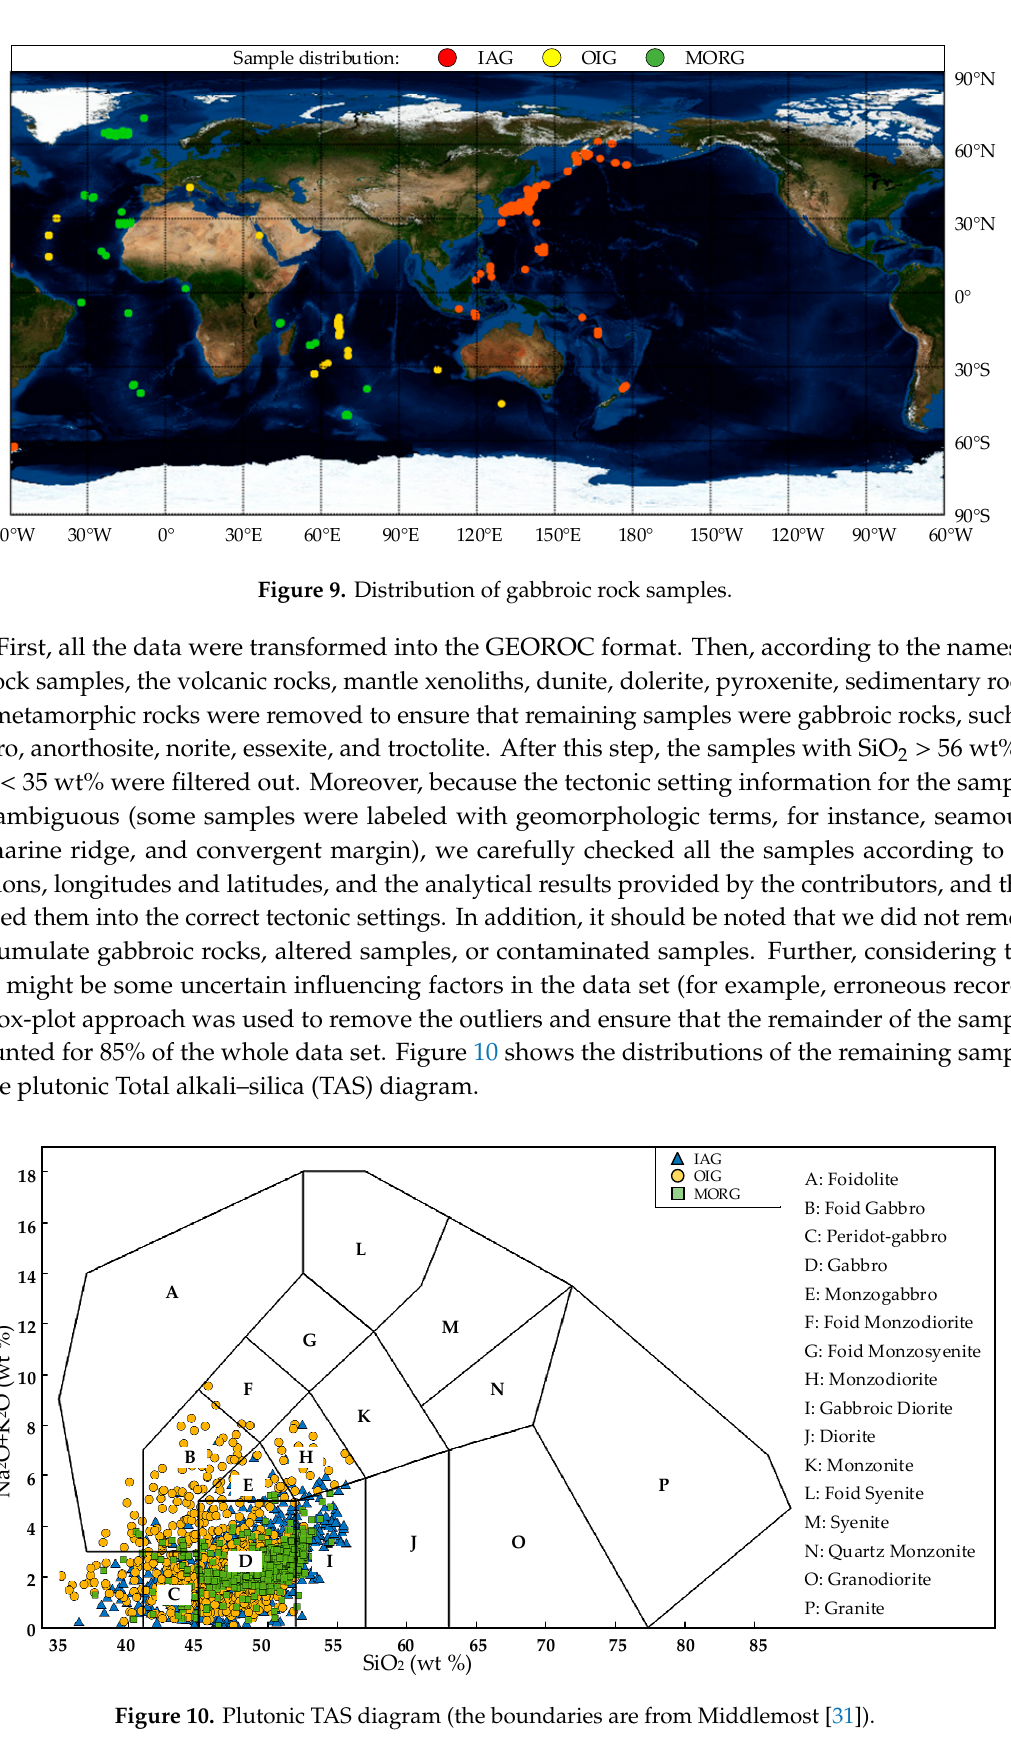
Table 1. Mean element contents of island-arc gabbroic rocks (IAG), ocean-island gabbroic rocks (OIG), and mid-oceanic ridge gabbroic rocks (MORG) samples. Basic Elements